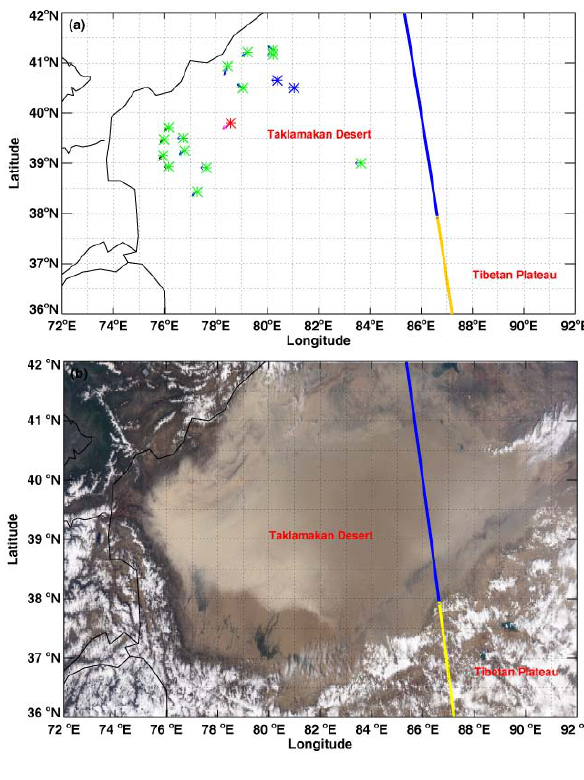
Fig. 3. Same as Fig. 1 except for 10 May 2007.